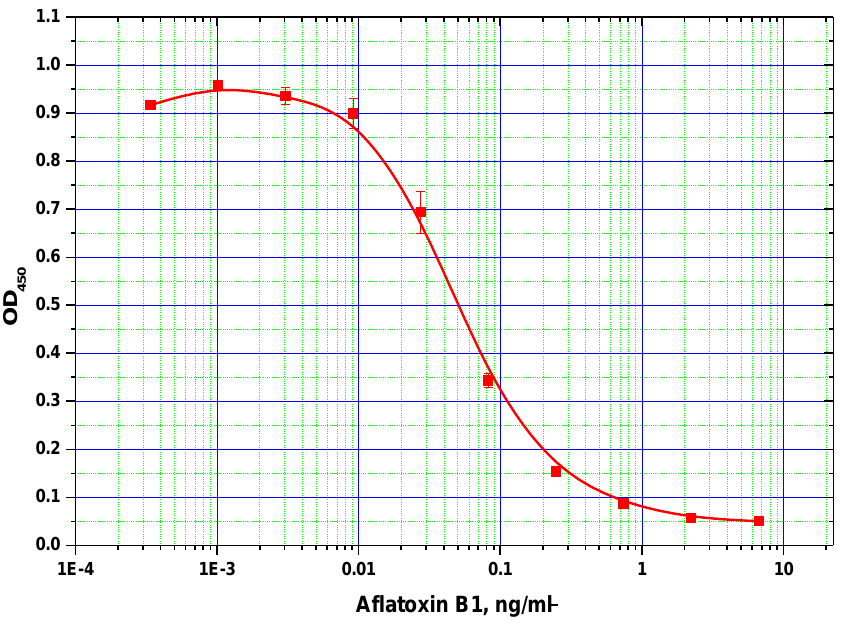
Figure 2. Calibration curve of conventional microplate ELISA for AFB1 detection. A limit of detection of 15 pg/mL was determined. The measurements were performed in